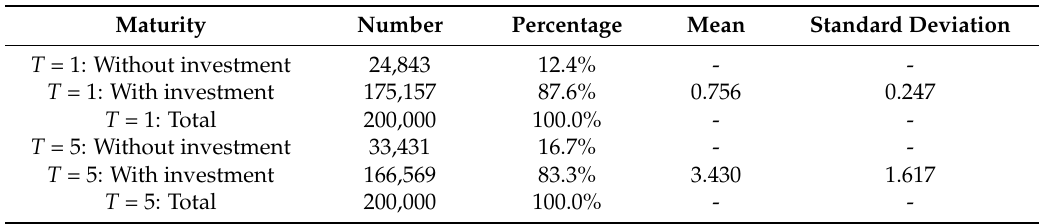
Table 5. Exercise of the option to defer investment.